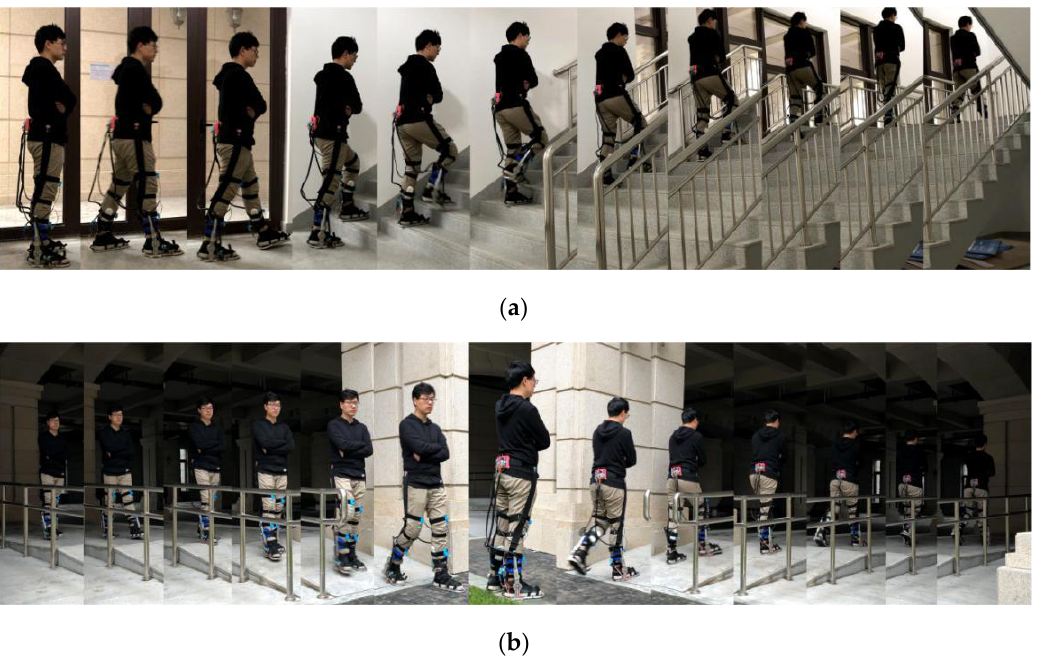
Figure 11. Two sets of experimental scenarios, ( a ) Mixed motion on horizontal sidewalks and stairs; ( b ) Slope and horizontal pavement mixing.